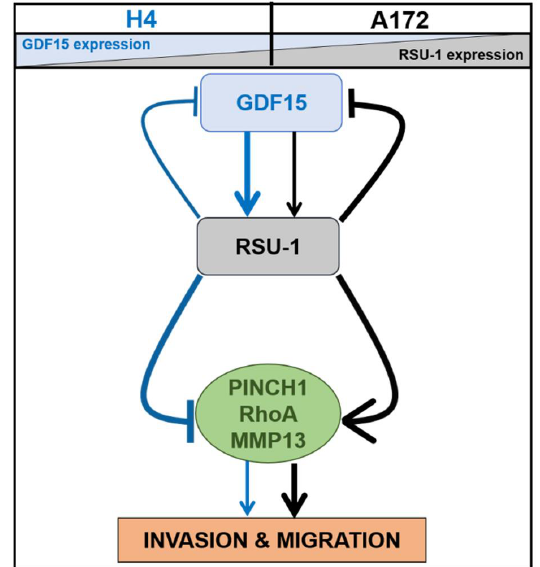
Figure 7. Schematic representation of the involvement of RSU-1 and GDF15 in regulating of H4 and A172 cell migration and invasion. The non-invasive H4 cells, endogenously express high levels of GDF15 and low levels of RSU-1 in contrast to the highly invasive A172 cells which endogenously express high RSU-1 and low GDF15 levels. This differential expression leads to a different behavior with regard to brain cell migration and invasion. In H4 cells, GDF15 induces RSU-1 , which in turn inhibits migration and invasion by inhibiting PINCH1 , RhoA and MMP-13 (solid blue arrows and lines). In the invasive A172 cells, GDF15 promotes RSU-1 which enhances migration and invasion through upregulation of PINCH1 , RhoA , and MMP-13 (solid black arrows and lines). Arrows used in the diagram are of different weight, so that thick arrows indicate stronger effect while thin arrows indicate weaker effect, further emphasizing the concept that expression levels of both RSU-1 and GDF15 are crucial in regulating glioma cell migration and invasion.